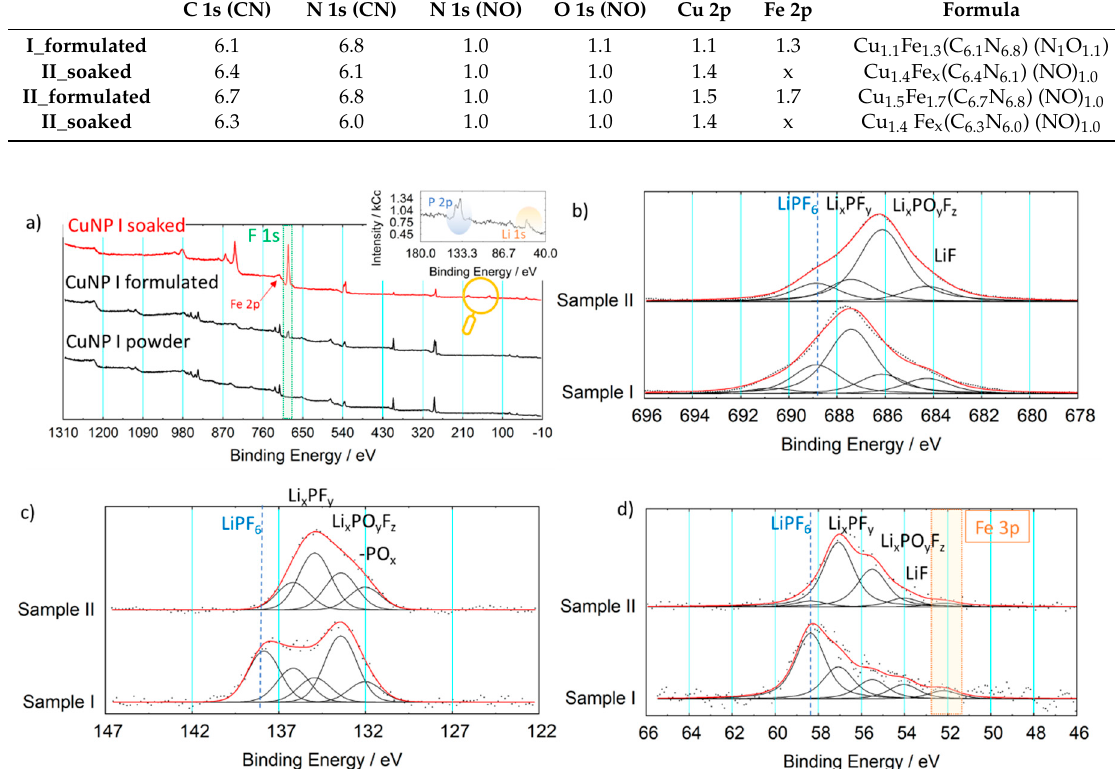
Figure 3. ( a ) Comparison of surveys of sample I. ( b – d ) Comparison between fitted data of the two samples. The detailed spectra reported are ( b ) F 1s ( c ) P 2p ( d ) Li 1s.